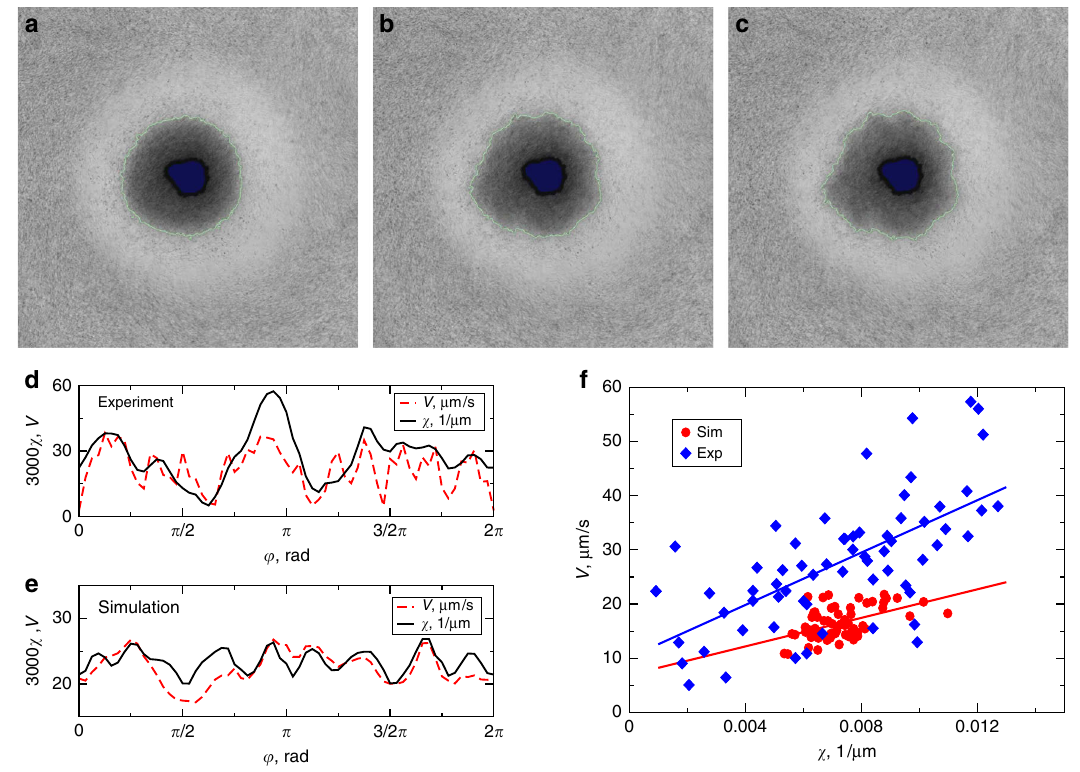
Fig. 3 Droplet's interface instability. The sequence of three consecutive snapshots illustrating the evolution of the dense droplet for times t = 0.15 s ( a ), t = 0.3 s ( b ), and t = 0.4 s ( c ) after cessation of rotation. The interface between dilute (bright) and dense (dark) regions is shown in green line. Rotation frequency is 400 Hz. Dependence of the interface velocity V (green) on the interface curvature ( χ ) for the exploding droplet 0.2 s after cessation of rotation. d , e Dependence of the interface velocity V (dashed red) and the interface curvature χ (solid black) on the polar angle φ for the experimental data ( d ) and the data obtained from simulations ( e ). A noticeable correlation between V and χ is observed both in experiments and simulations. f Parametric dependence of the interface normal velocity V vs curvature χ for experimental data (blue diamonds) and simulations (red circles). Two lines are linear regression fi